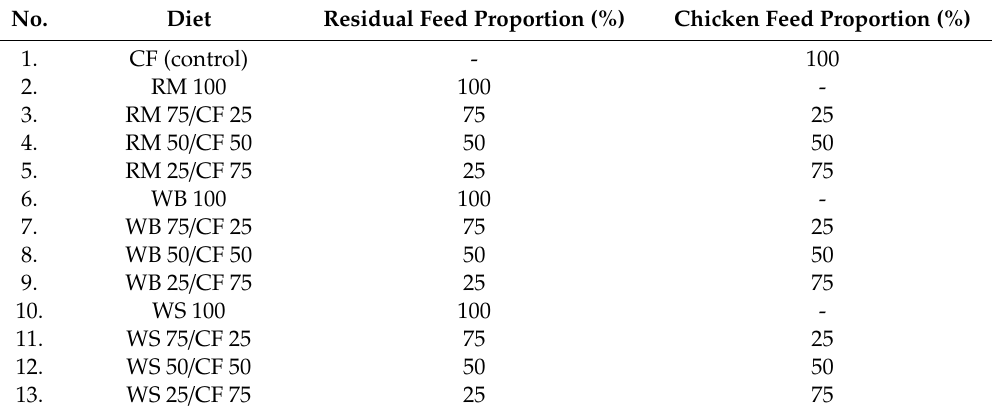
Table 2. Composition of experimental diets for the feed conversion